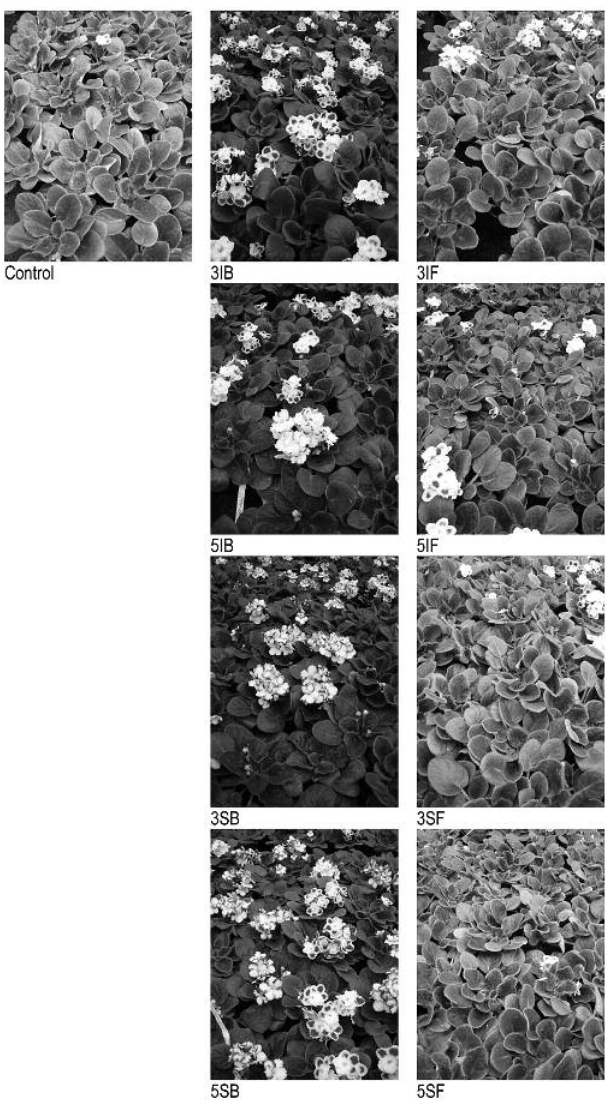
Figure 7. The effect of treatments on flowering of Saintpaulia ionantha (20 th February